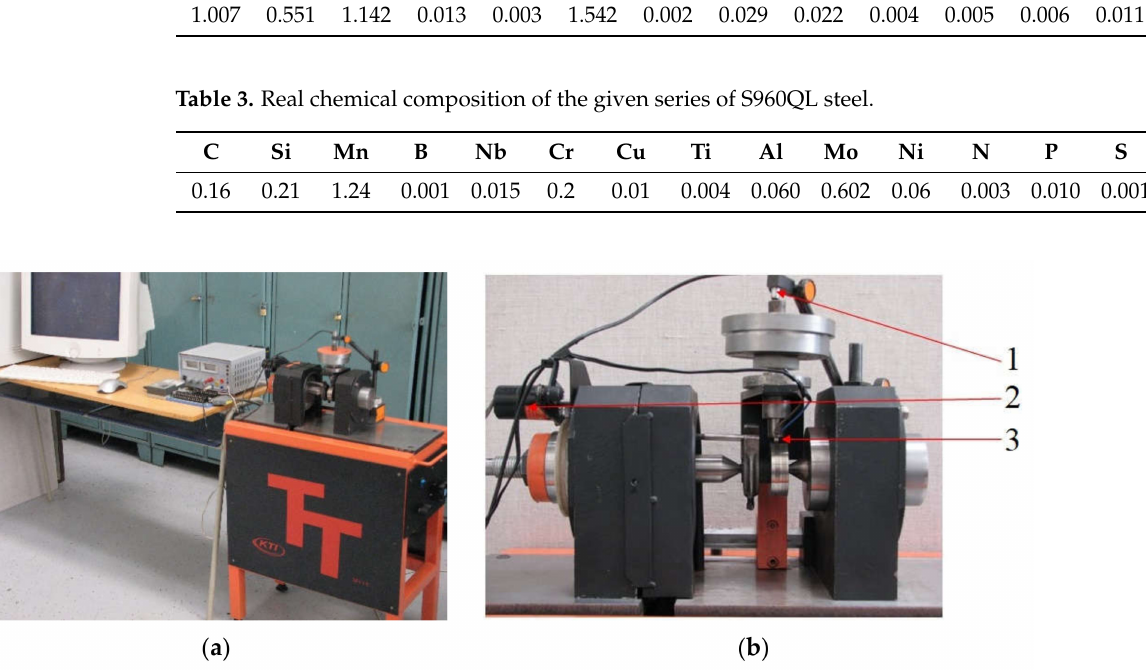
Figure 7. The experimental workplace for measuring the material wear: ( a ) A layout in a laboratory. ( b ) The detail of the device (1—the measuring element TESA; 2—speedometer; 3—a test specimen with a